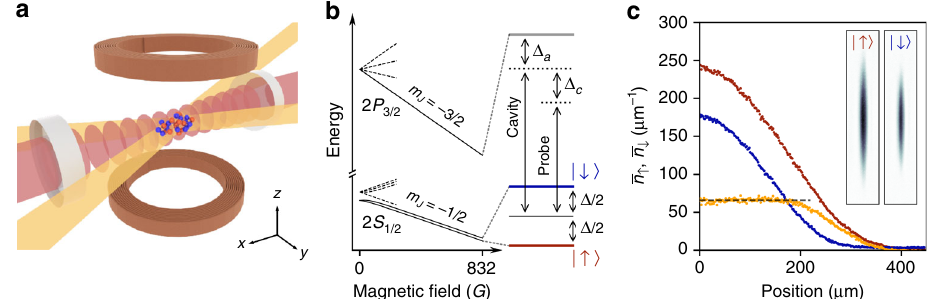
Fig. 1 Combining a unitary super fl uid with a high- fi nesse cavity. a A two-component Fermi gas is trapped in a crossed-dipole trap aligned onto the mode of a high- fi nesse optical cavity. A bias magnetic fi eld oriented along the z -axis controls the interactions between the atoms. b Relevant energy levels of 6 Li at 832 G including the frequencies of the probe laser and cavity resonance. In the experiment the detunings Δ a and Δ c are varied independently. c Doubly integrated density pro fi les, n " and n # , along the longitudinal direction after transfer in an elongated trap, for 9.3(5) × 10 4 and 6.0(3) × 10 4 atoms in state "j i (red) and #j i (blue), respectively. The difference between the two doubly integrated pro fi les (orange) exhibits a plateau, characteristic of a super fl uid core surrounded by a polarized shell. The grey dashed line is horizontal to guide the eye. Inset: absorption images (173 × 919 μ m) taken along the z- axis of both spin states in the elongated trap after 300 μ s time-of- fl ight. The peak line density is 244 μ m − 1 .